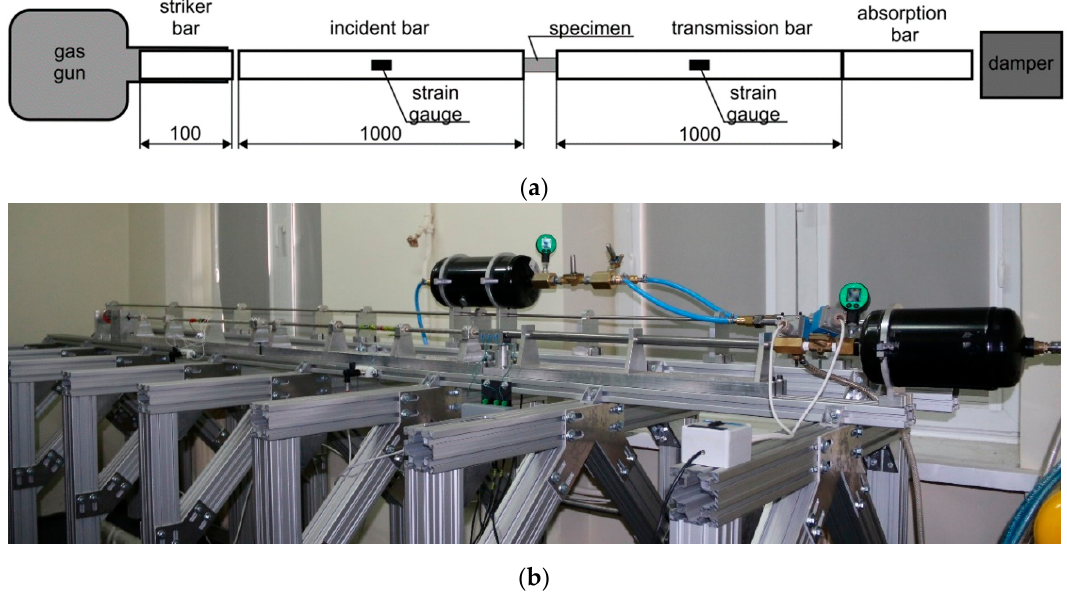
Figure 1. Split Hopkinson pressure bar arrangement; ( a ) schematic illustration; ( b ) experimental setup.